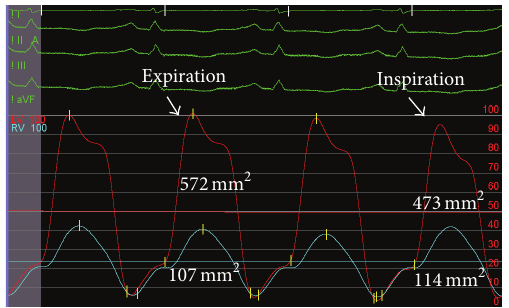
Figure 4: Elevated and equalized telediastolic pressure in ventricles (20 mmHg, arrow head); systolic area index calculated as the ratio between right ventricle/left ventricle systolic area in inspi- ration and right ventricle/left ventricle systolic area in expiration: (114/473)/(107/572) = 1.29.